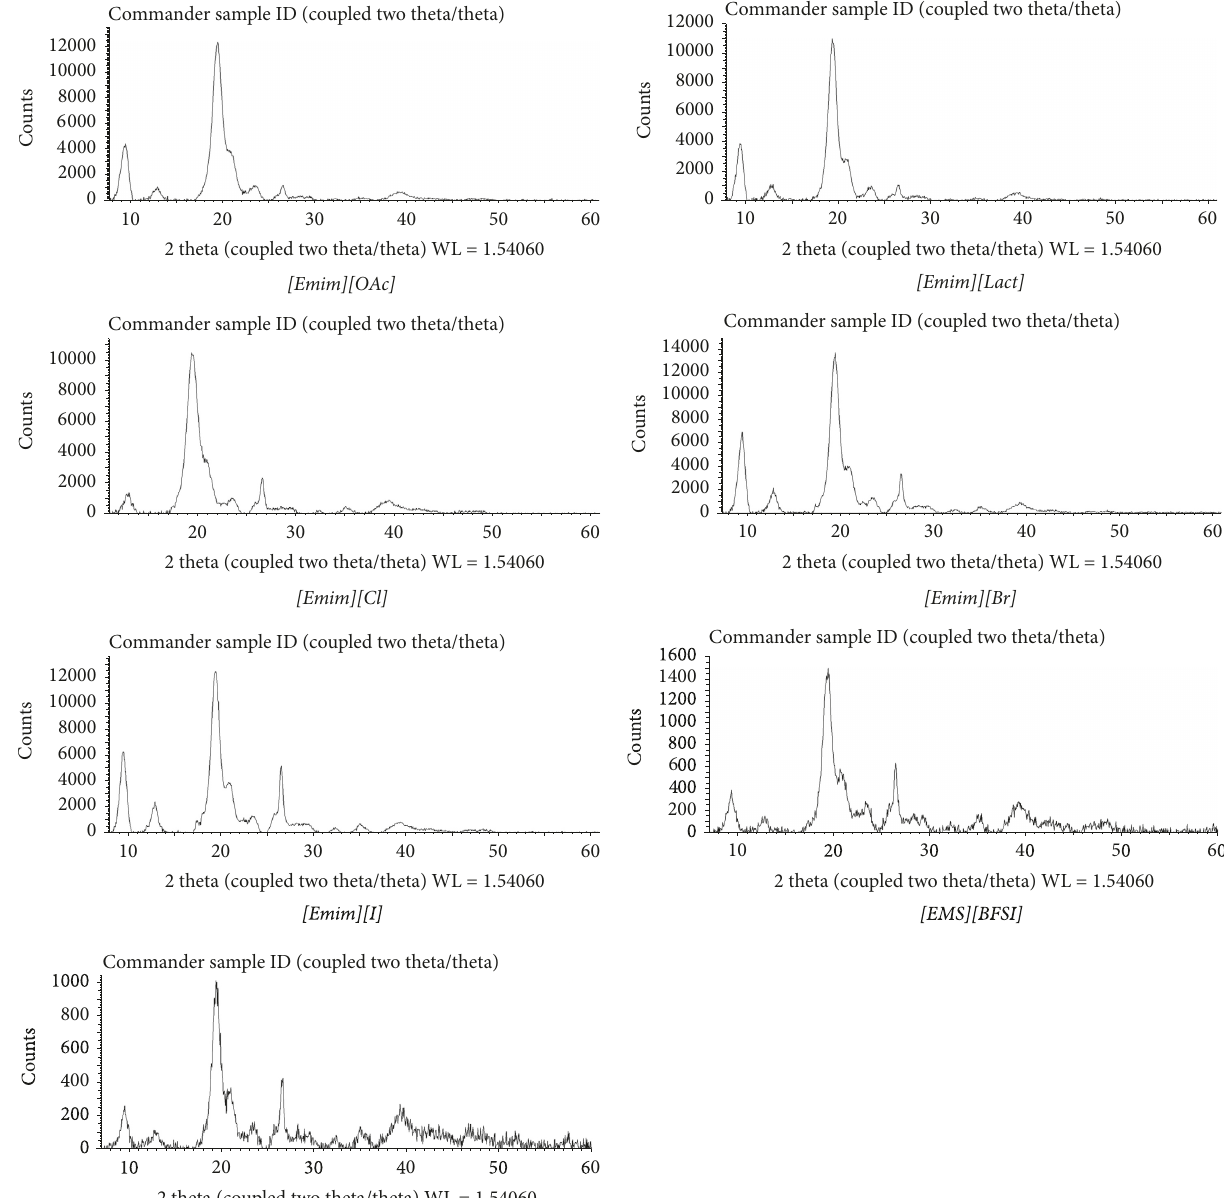
Figure 3: XRD patterns of regenerated chitins regenerated in 4s